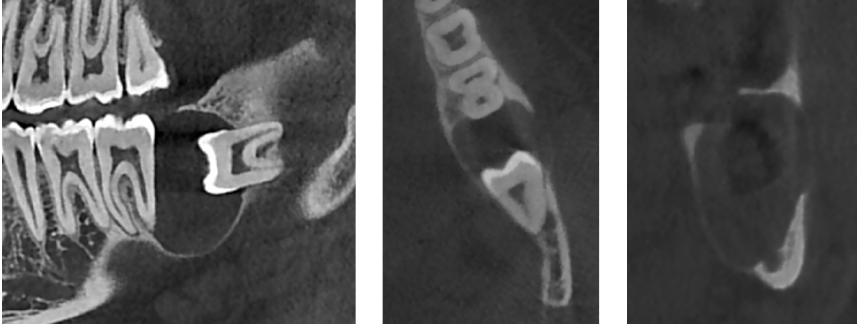
Figure 2. CBCT X-ray of case #1.